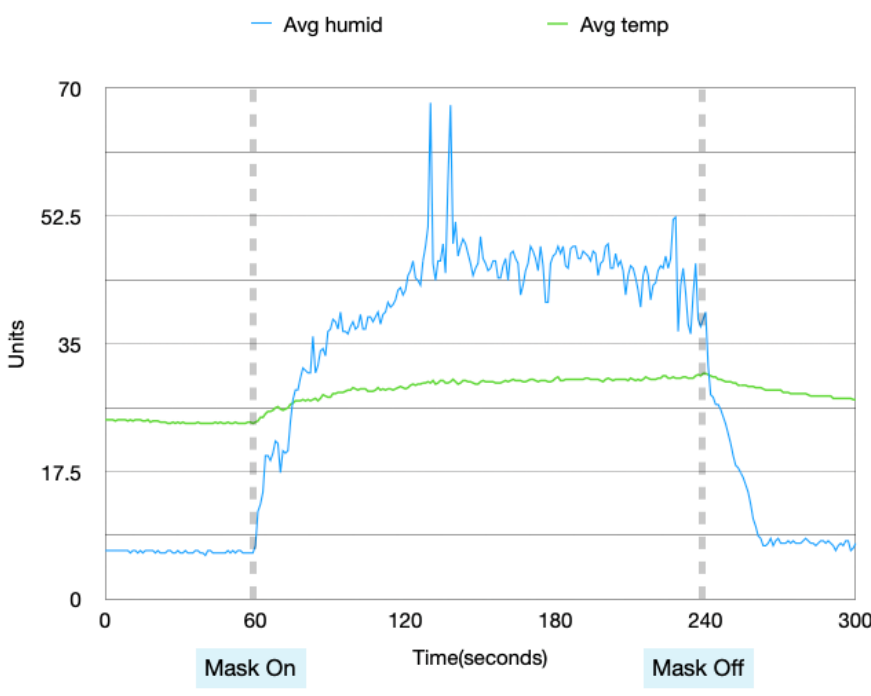
Figure 4. Humidity and temperature collected during the day, with no prior physical activity.